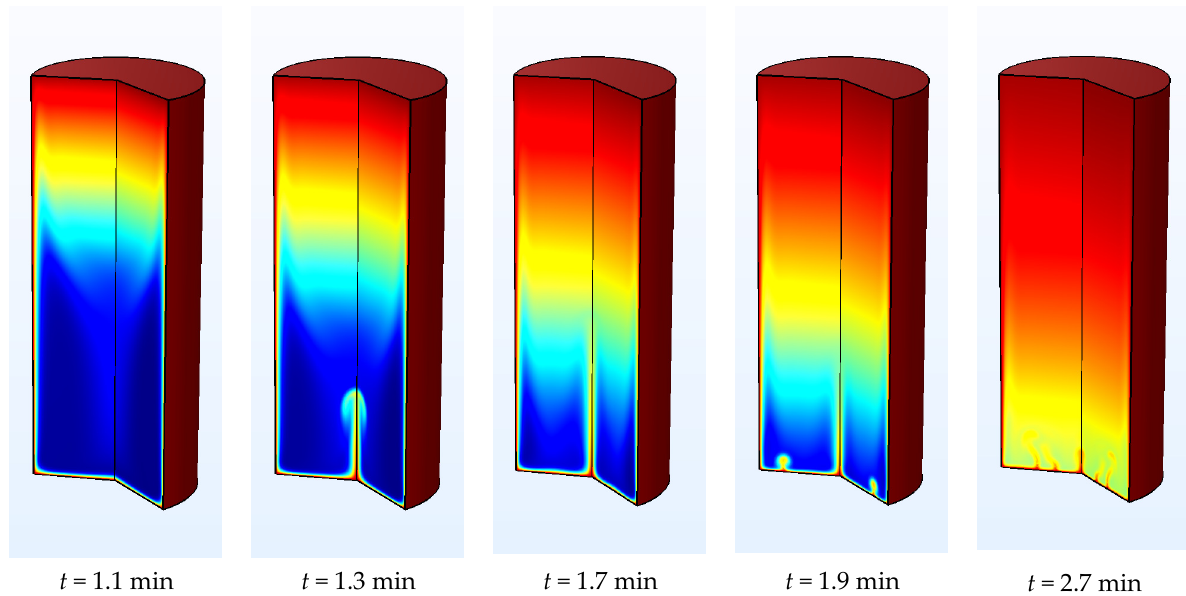
Figure 7. Temperature distributions at various times during the heating stage for T 0 = 22 °C (blue) and T 1 = 150 °C (red).